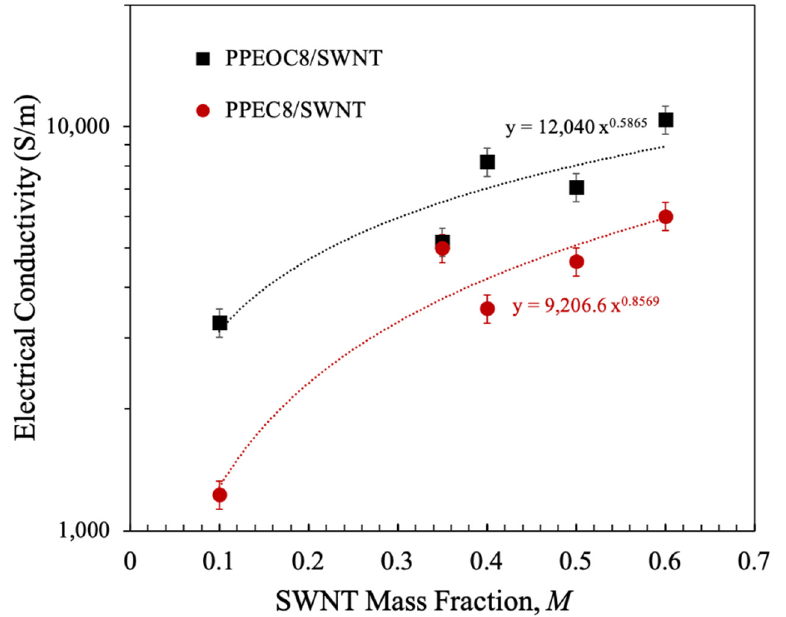
Figure 9. Data of electrical conductivities versus SWNT mass fraction for PPEC8/SWNT and PPEOC8/SWNT nanocomposites. The dashed lines are a power-law fit.